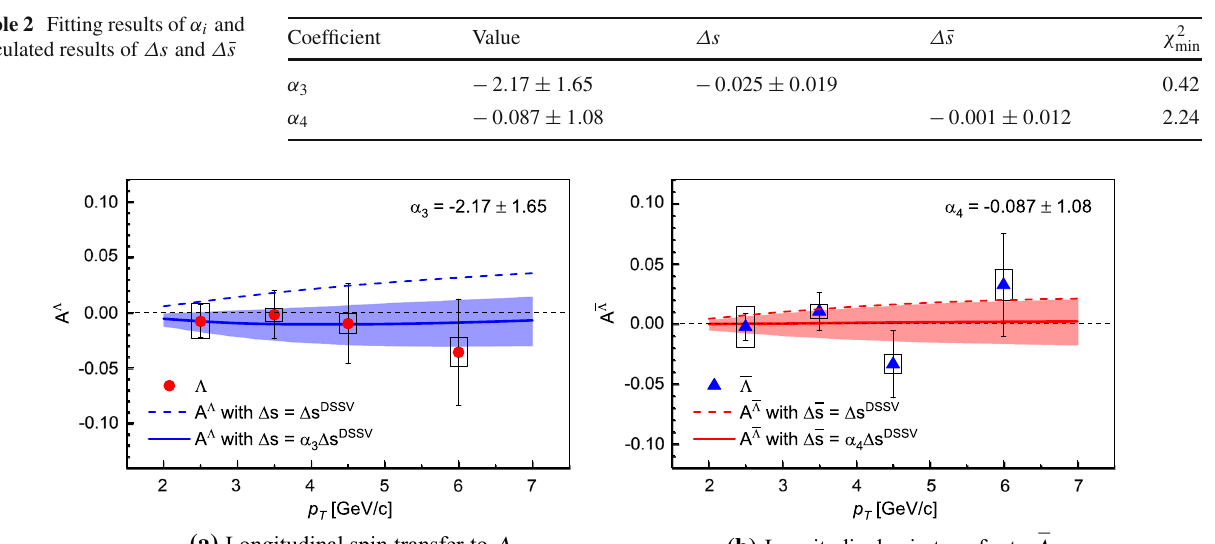
Fig. 5 Comparison of the measured spin transfer data with the- mentation. The symbols and curves are identical with Fig. 4. √ ¯ Λ More details about the fitting results of α i are presented in s = ory predictions A Λ and A for positive η versus p T at 200GeV, including the contribution from the polarized gluon frag-